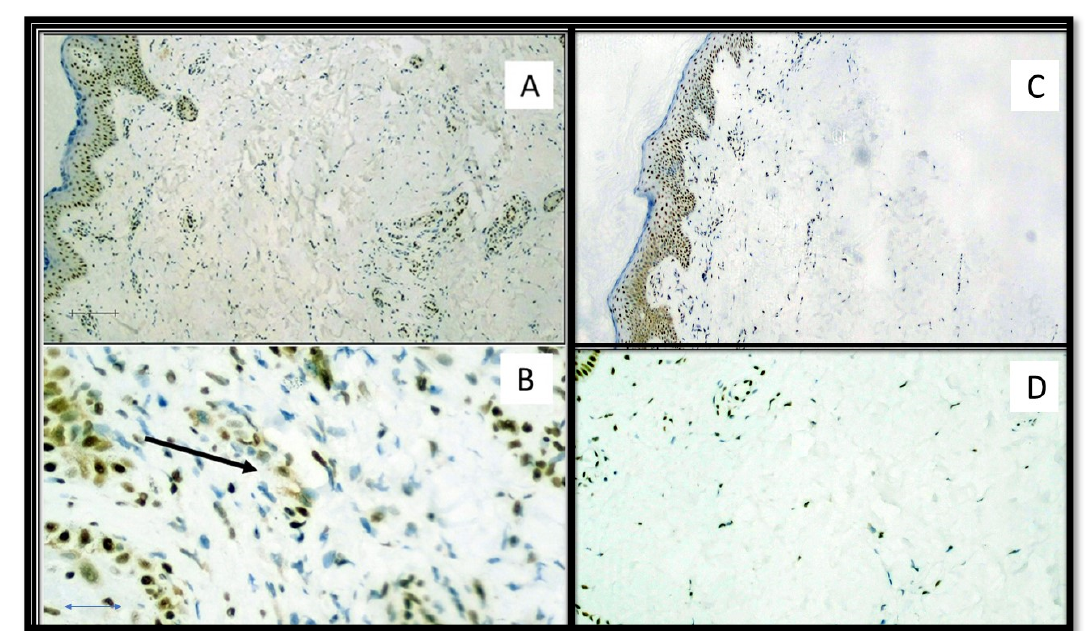
Figure 4. ( A ) Immunostaining for HMGB1 of a patient positive for SARS-CoV-2: note the internal positive control of normal epidermal keratinocytes and positivity in the cells constituting the excretory portion of the eccrine sweat glands that were strongly positive for anti-S1 spike protein immunostaining by SARS-CoV-2 (Immunohistochemistry, Original Magnification: 40 × ). ( B ) Detail of extracellular release of HMGB1 (Immunohistochemistry, Original Magnification: 200 × ). ( C ) Immunostaining for HMGB1 of a patient negative for SARS-CoV-2: note the internal positive control and substantial negativity in the cells of superficial dermis (Immunohistochemistry, Original Magnification: 40 × ). ( D ) Detail of negativity for HMGB1 (Immunohistochemitry, Original Magnification: 100 × ).